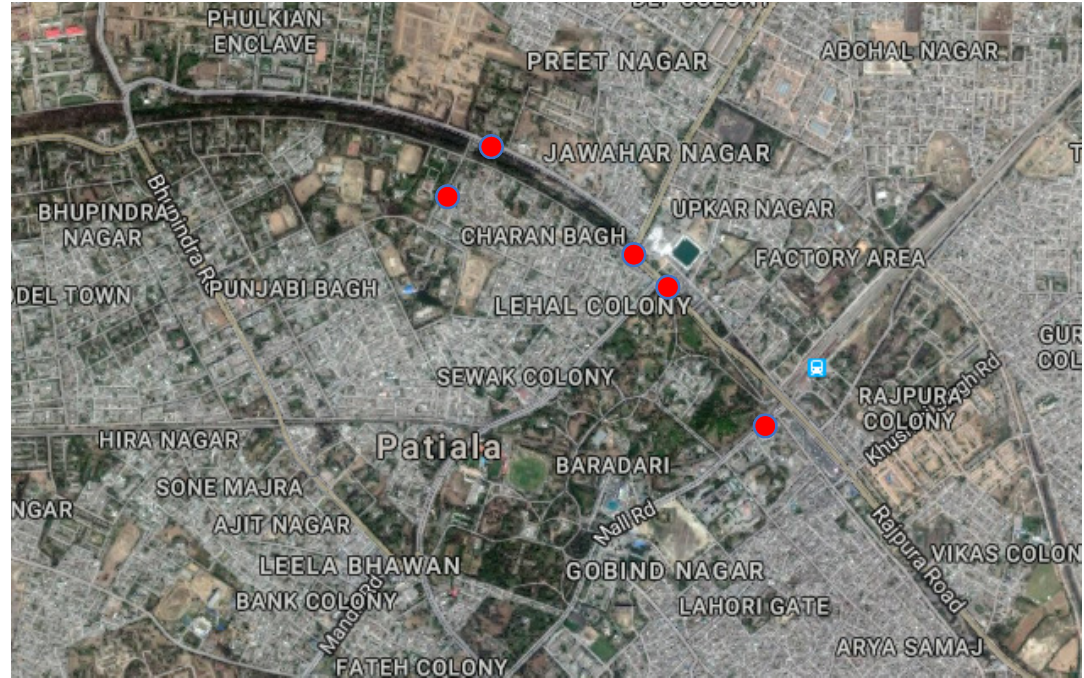
Figure 1. Area under study and sites of measurement (courtesy of Google